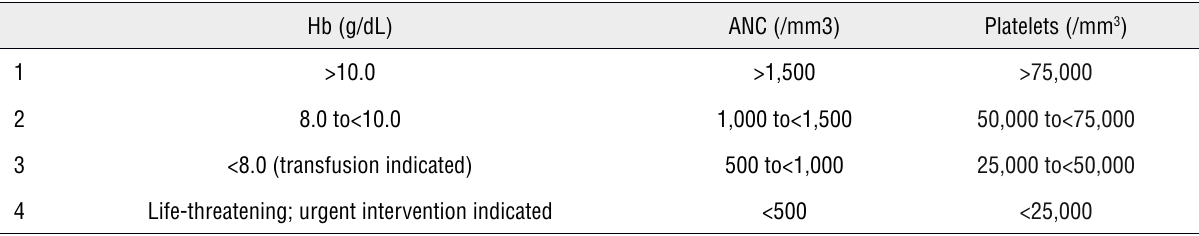
Table 2 - Hematologic toxicity (according to WHO